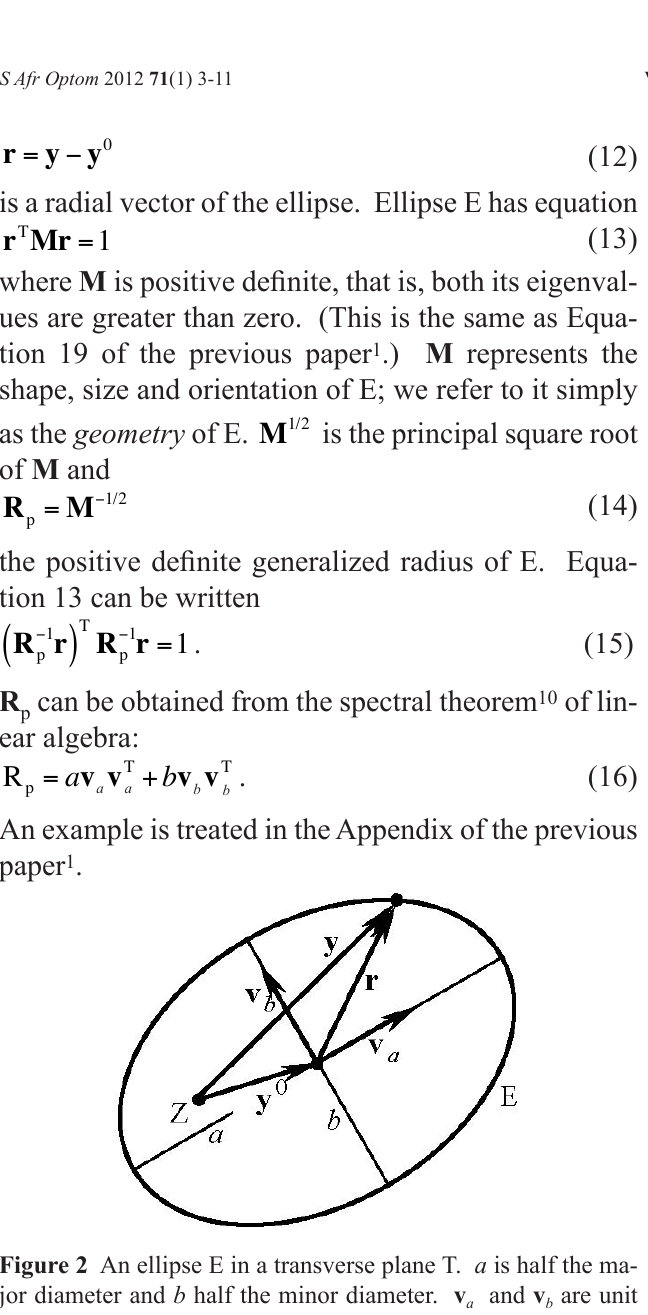
and v are unit a b